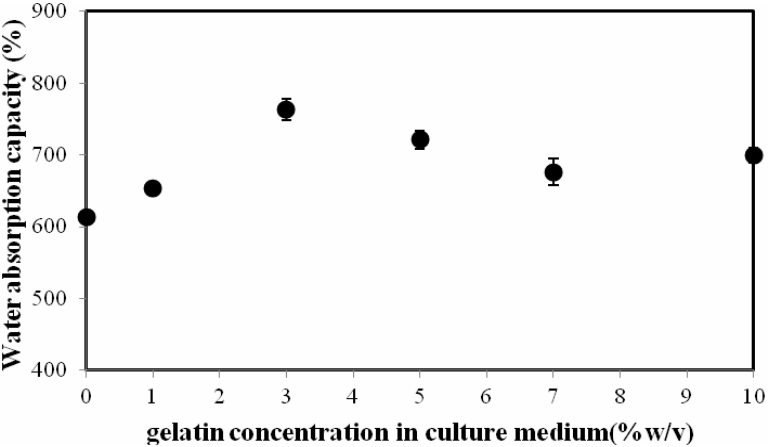
Figure 6. The water absorption capacity of the BC and BCG films as a function of gelatin concentration in culture medium.